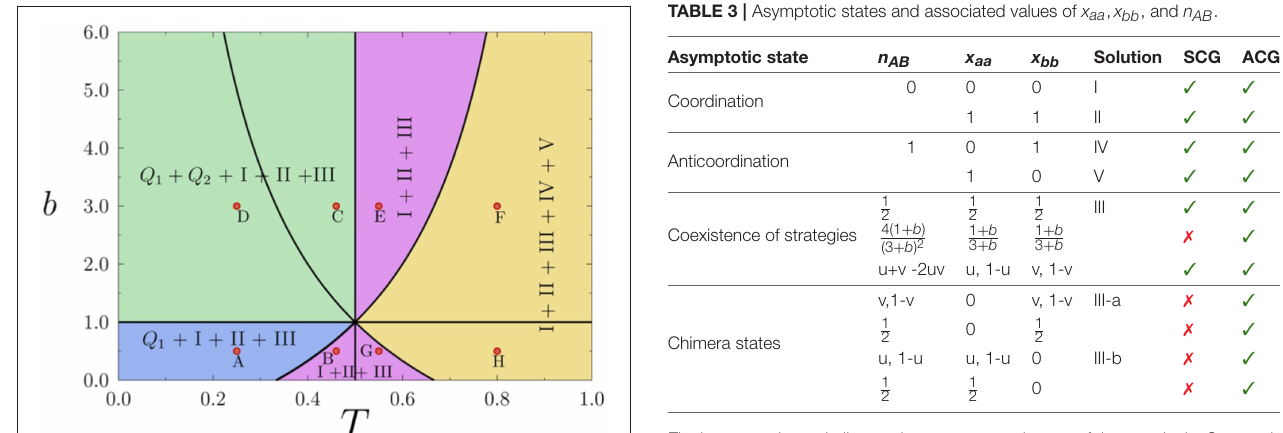
The last two columns indicate existence or non-existence of the state in the Symmetric Coordination Game (SCG) and in the Asymmetric Coordination Game (ACG). The parameter b corresponds to the risk parameter of the ACG and the numbers u ,1 − u and v ,1 − v for u , v ∈ (0,1) describe the family of periodic solutions in layer A and layer B respectively. Chimera states in which the three variables x aa , x bb , and n AB take constant values, either 0 or 1/2, correspond to the case in which the disordered layer is in a solution III